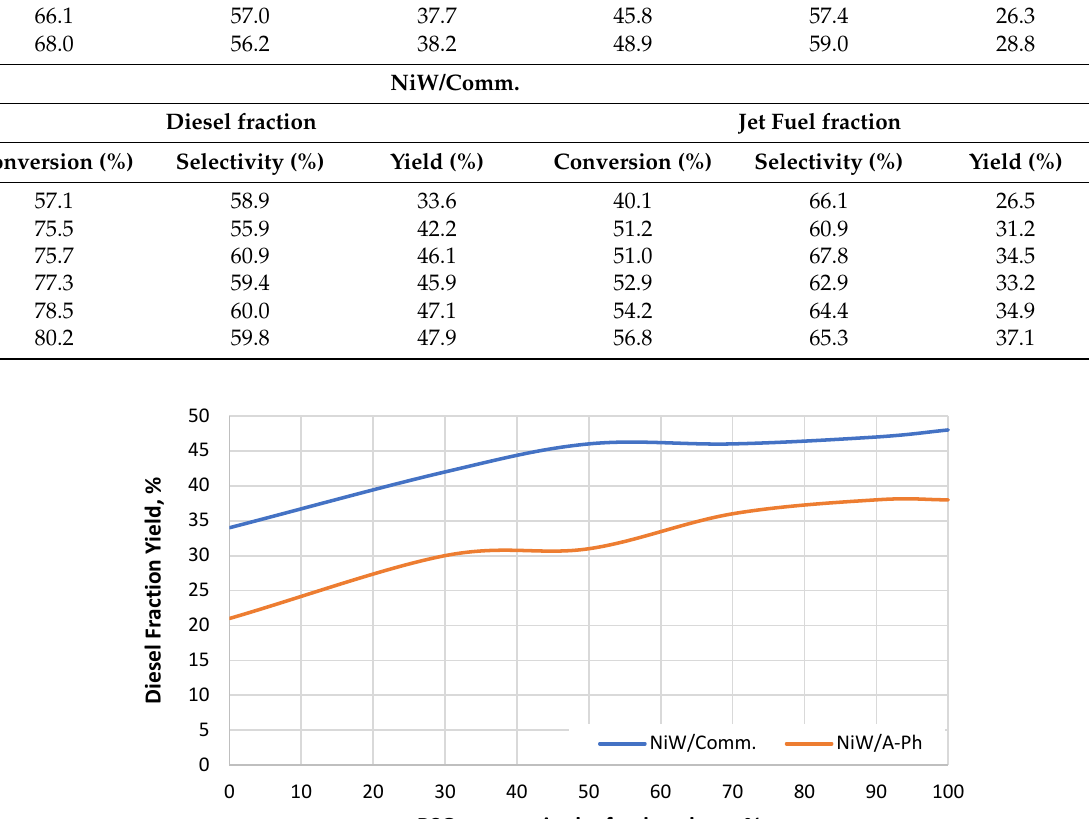
Figure 8. Jet fuel fraction yield gained throughout the experiment using both tested NiW catalysts (NiW/A ‐ Ph, NiW/Comm.) depending on the RSO content in the processed feedstock blend. Regarding diesel fraction yield (Figure 7), the differences between the two tested NiW catalysts were rather constant throughout the experiment. Both catalysts showed the best results when pure RSO was the feedstock. This result could be related to the previous obtainment of linear paraffins by HDO, and their subsequent hydrocracking to diesel, jet fuel, and other products. The VGO contains not only linear paraffins but also other types of hydrocarbons such as aromatic and naphtenes. In addition, the relatively short time of reaction (48 h), even when having a feedstock with sufficient sulfur content, was not enough to cause loss of efficiency at the active sites (metal sulfides and loss of sulfur). It would be expected to see severe deactivation due to sulfur leaching when processing RSO for a longer time. Phonolite is a novel potential raw material for use as a catalyst support. With its acid modification, the phonolite acquires porous properties with a significant surface area,